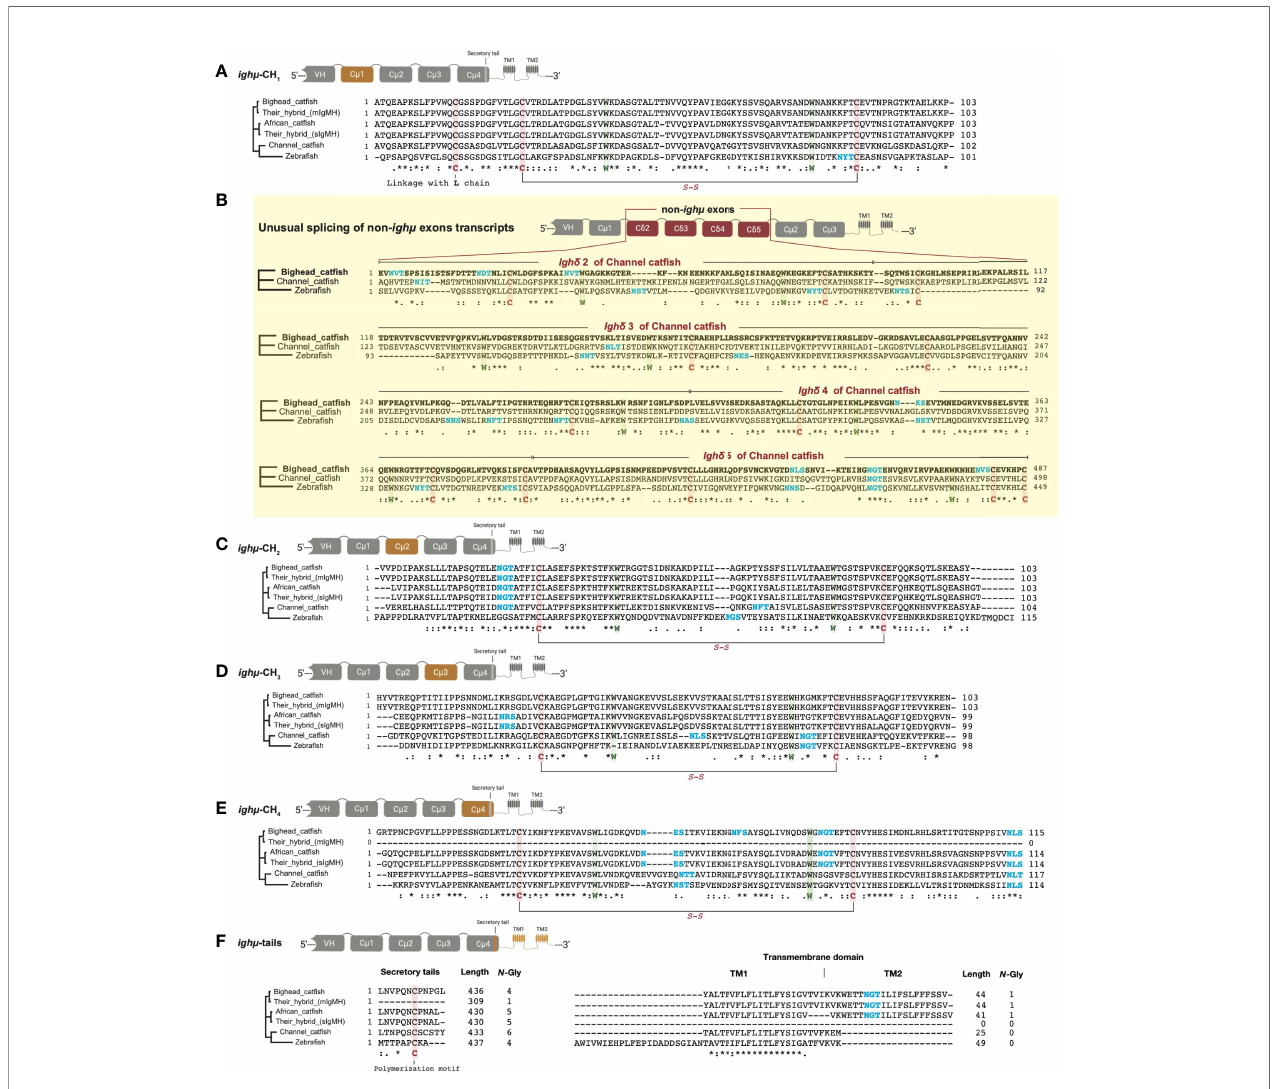
FIGURE 2 | Comparisons of translated amino acids among bighead cat fi sh, North African cat fi sh, their hybrid cat fi sh, channel cat fi sh and zebra fi sh in different Igh m - coded exons found in this study: C m 1 exon (A) , non- Igh m exon (B) , C m 2 exon (C) , C m 3 exon (D) , C m 4 exon (E) and Igh m tail exon (F) . *, fully conserved residue of amino acids that play the same role in the same